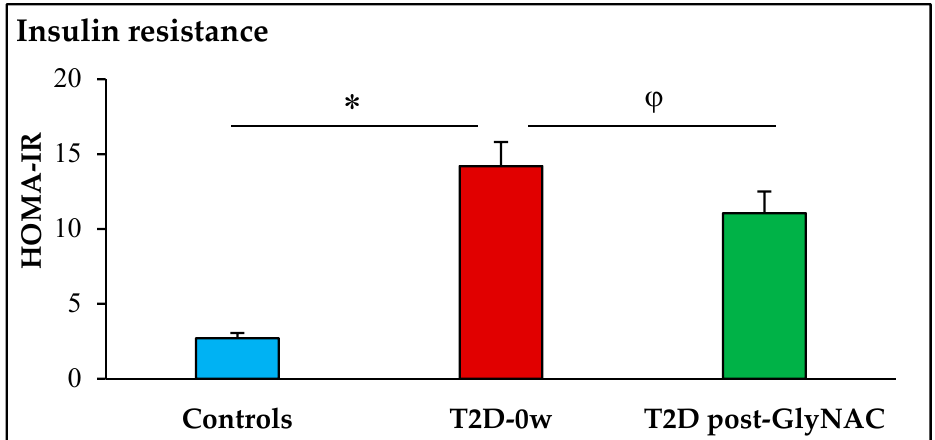
Figure 2. GlyNAC supplementation lowers insulin resistance in participants with Type 2 diabetes. HOMA-IR = homeostatic model assessment for insulin resistance; T2D-0w = participants with Type 2 diabetes before GlyNAC supplementation; T2D post-GlyNAC: participants with T2D 2 weeks after GlyNAC supplementation. ∗ = p < 0.001; ϕ = p < 0.01.